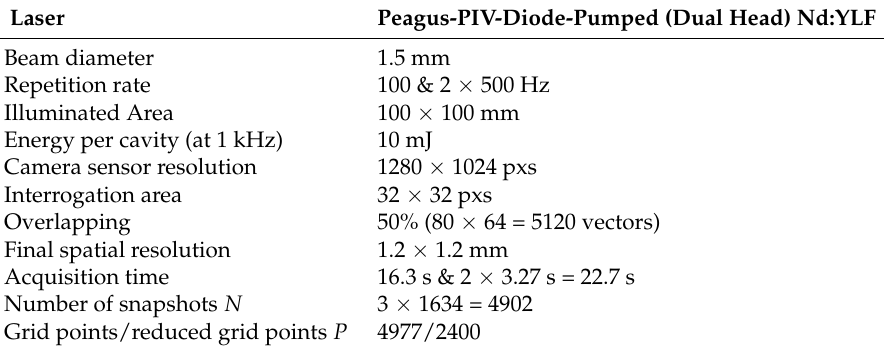
Table A1. Parameters of the